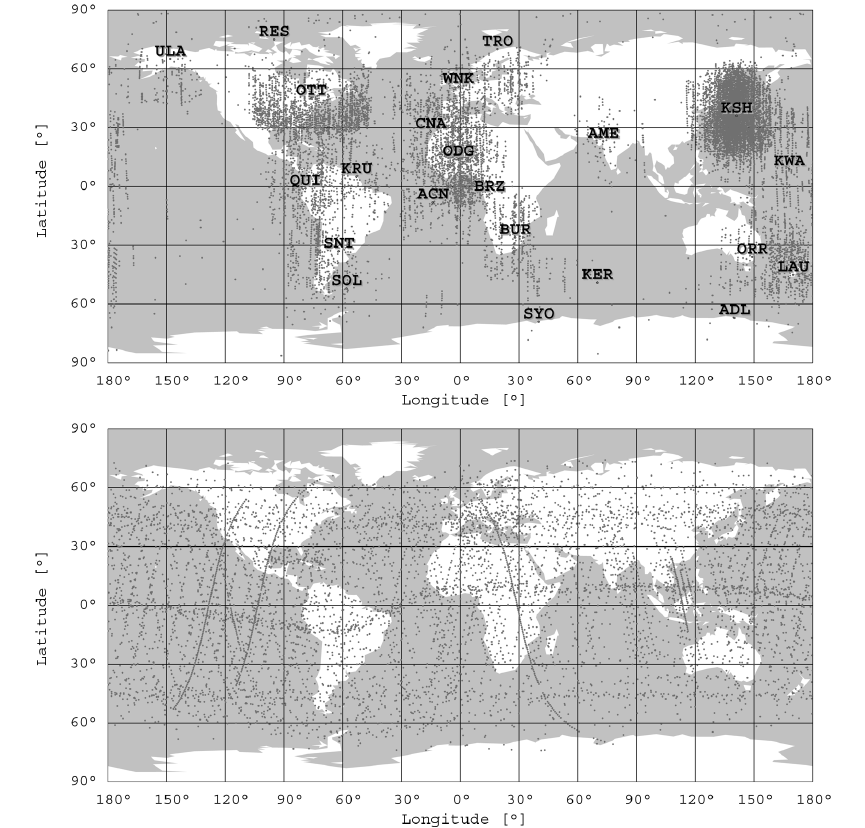
Fig. 1. Locations of the available profiles: (top panel) ISIS2 data, names indicate the telemetry stations used; (bottom panel) IK19